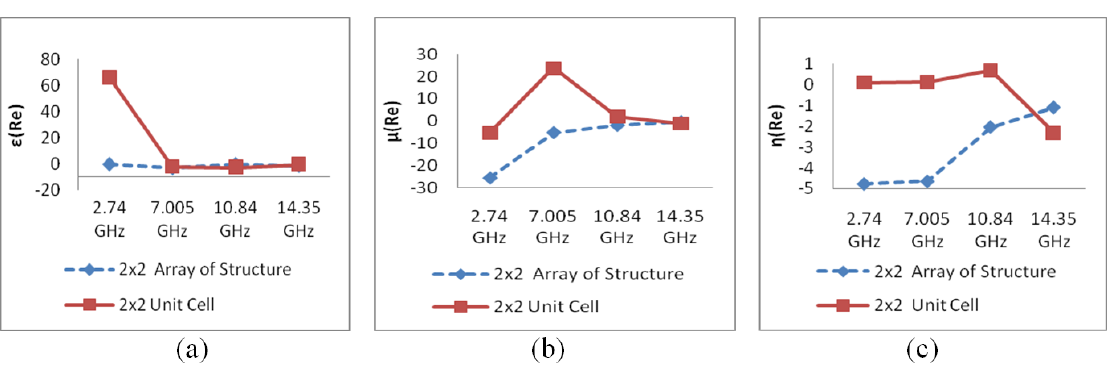
Figure 19. ( a ) ε-value comparison of 2 × 2 configurations; ( b ) µ-value comparison of 2 × 2 configurations; ( c ) η-value comparison of 2 × 2